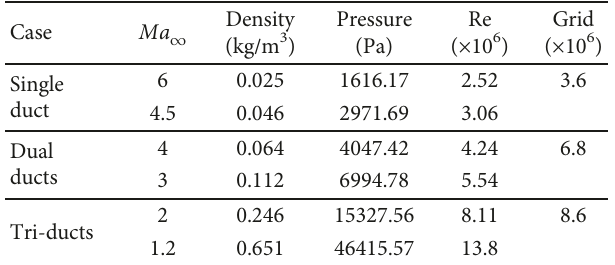
Table 1: Summary of the fl ight conditions for the di ff erent working